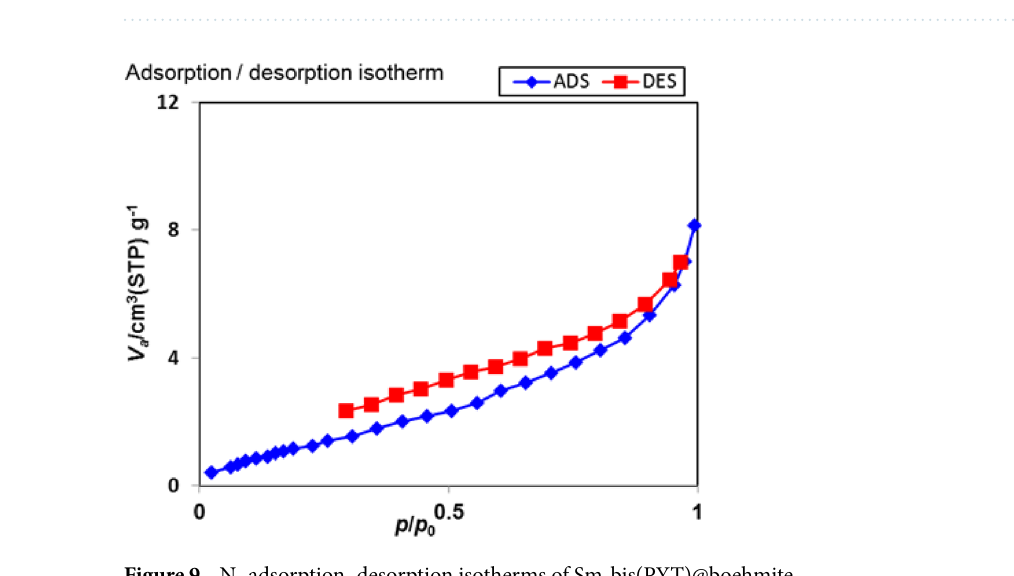
Figure 8. Normal XRD pattern of Sm-bis(PYT)@boehmite.